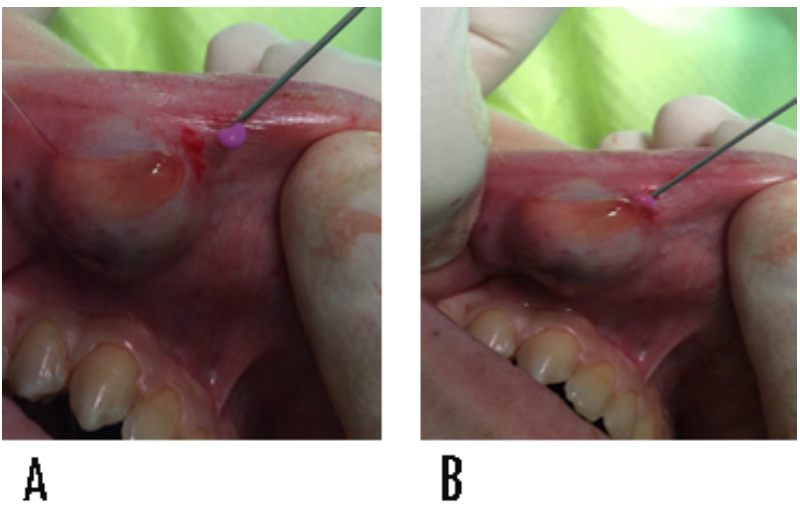
Figure 2. ( A , B ) Injection of hydrocolloid impression material (alginate) by syringe into the lumen of the mucocele. The technique prevents the collapse of the wall of the lesion, safeguarding the health of the surrounding tissue.